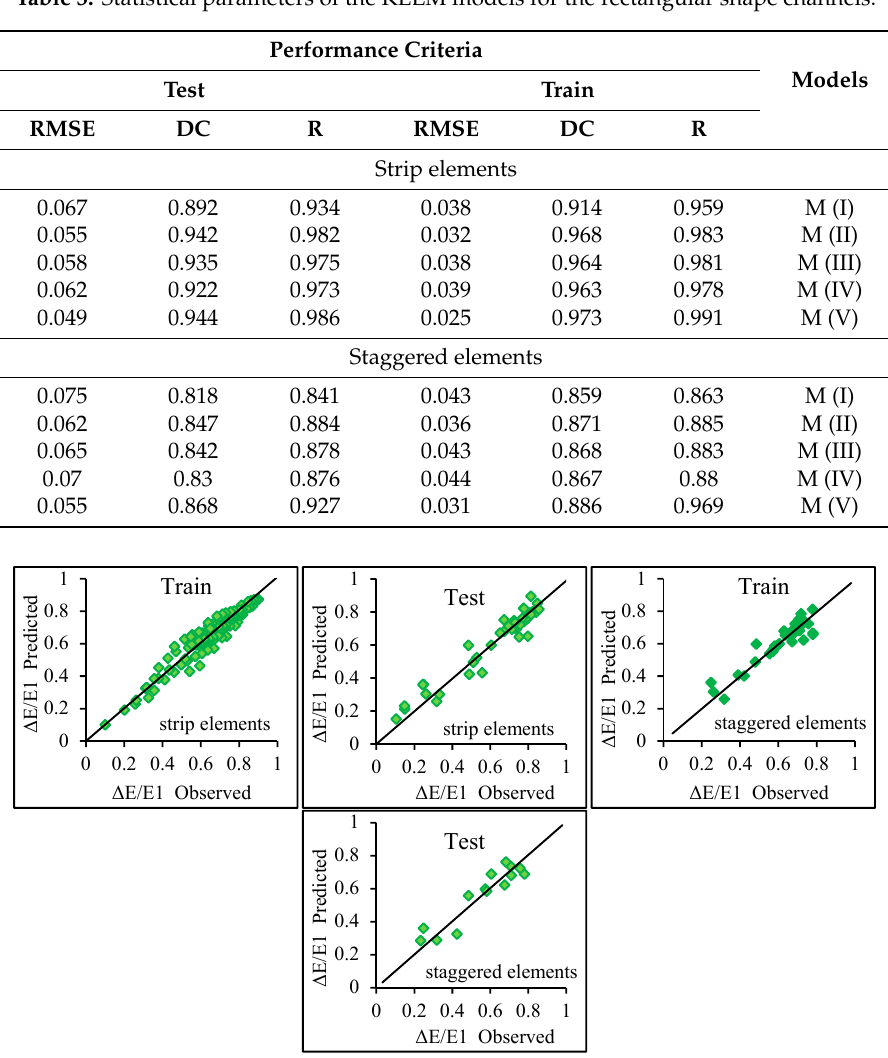
Figure 4. Comparison of observed and predicted energy dissipation for the rectangular shape channels superior models.